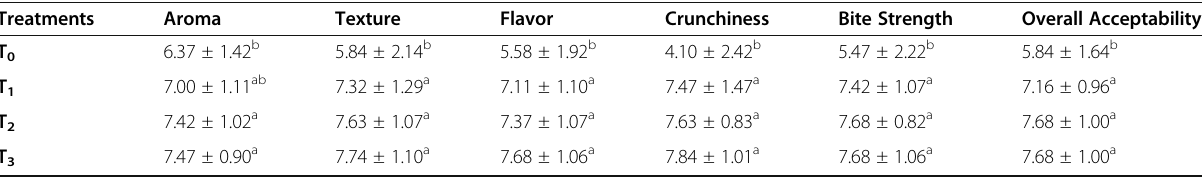
Table 4 Mean values for sensory attributes of fox nuts snack treatments